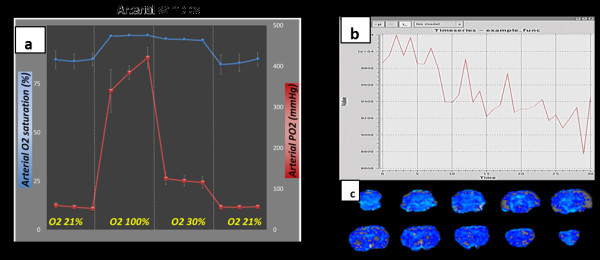
 Changes in arterial O2saturation and PO2and examples of whole pattern activation. (a) Changes in arterial O2 saturation and PO2 under different O2 gas concentrations during anaesthesia. These parameters can affect the BOLD response during MRI; therefore, it is important to monitor blood gas levels during such functional MRI studies [54]. (bc) Example of whole pattern activation in a rat brain erratically induced by too deep isoflurane anaesthesia. Such a ‘bad’ activation pattern in the whole brain (c) would mask any specific activation due to a pharmacological and/or sensorial stimulus, and in this case, the time course shows (b) a general decline in signal, and no effect of the challenge is visible.